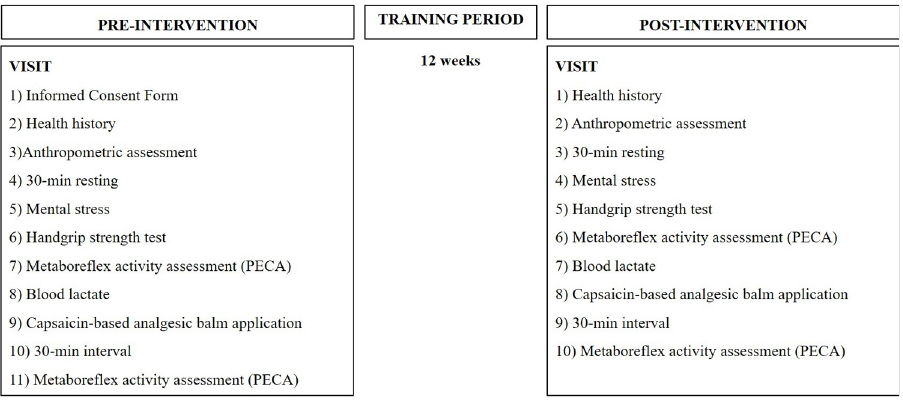
Fig 3. Experimental